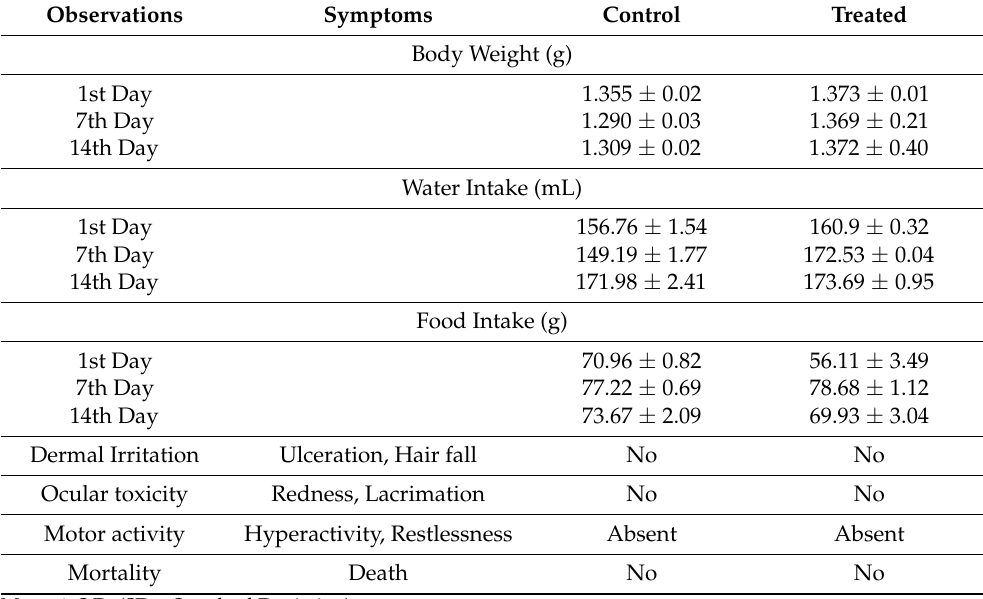
Table 4. Parameters for assessing acute oral toxicity.